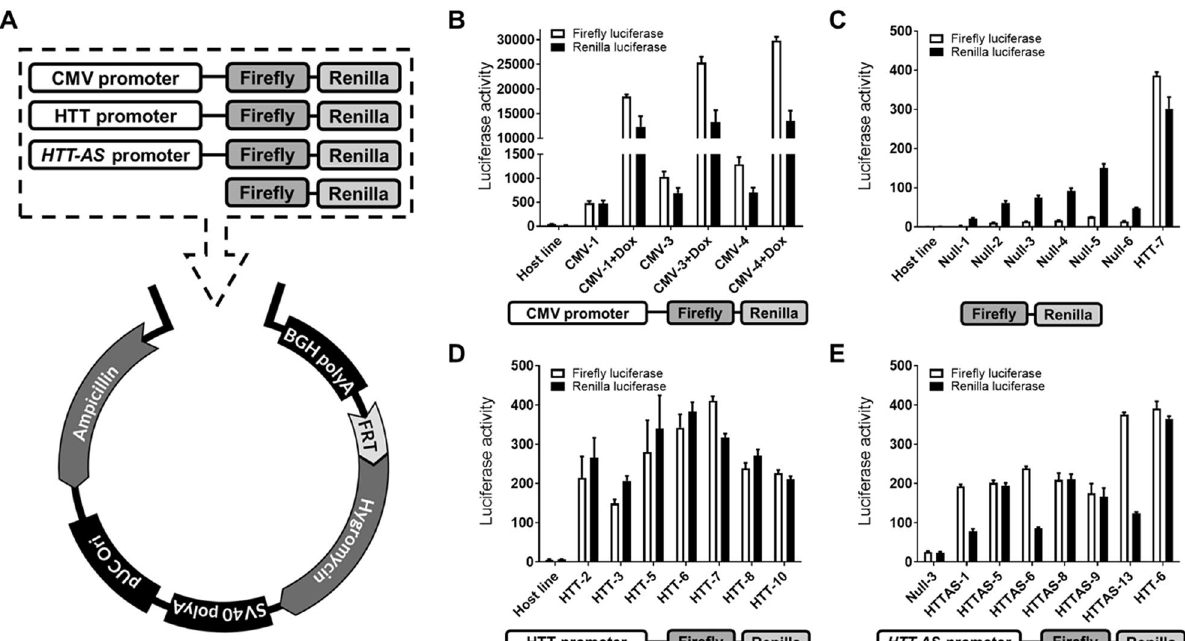
Figure 1. Strategy for generation of stable cell lines. ( A ) Constructs containing a promoter linked to two luciferase reporters were cloned into a pcDNA5/FRT backbone. Plasmids were transfected into HEK293 host cells with an integrated Flp recombination site. ( B – E ) Baseline luciferase activity was assayed in clones expressing firefly linked to ( B ) CMV promoter, with or without doxycycline (Dox) treatment (n = 3), ( C ) no promoter (“Null”; n = 4), ( D ) HTT promoter (n = 4), and ( E ) HTT-AS promoter (n = 4). Raw luminescence signal values are shown (luciferase activity); error bars are ±